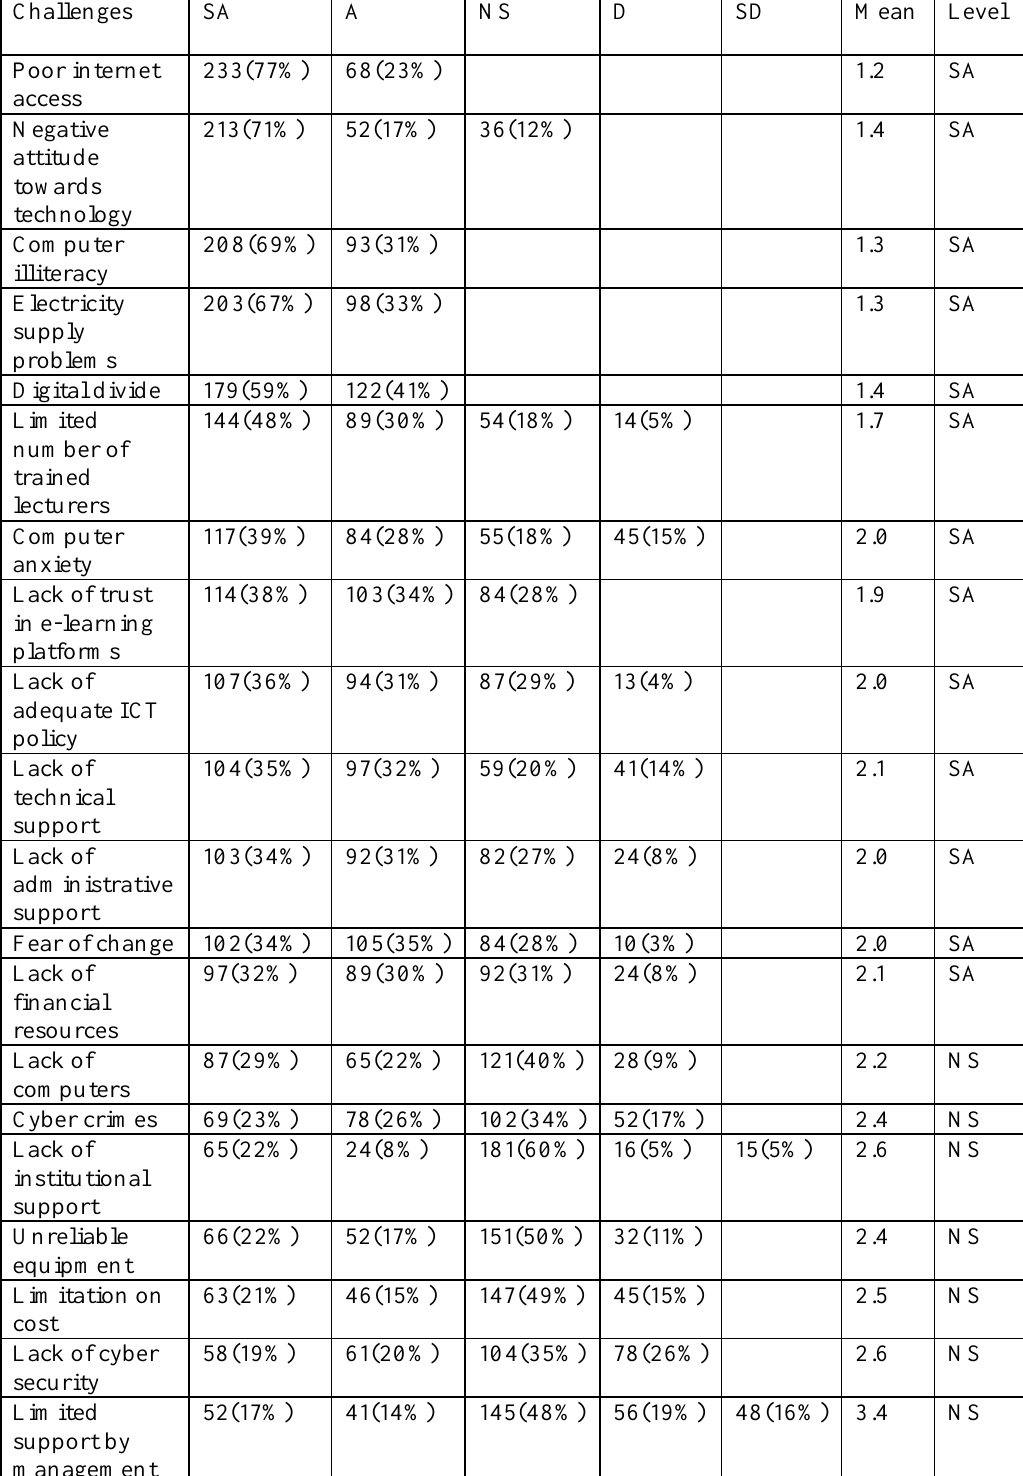
Table 5 Challenges Faced By Lecturers and Students (N =